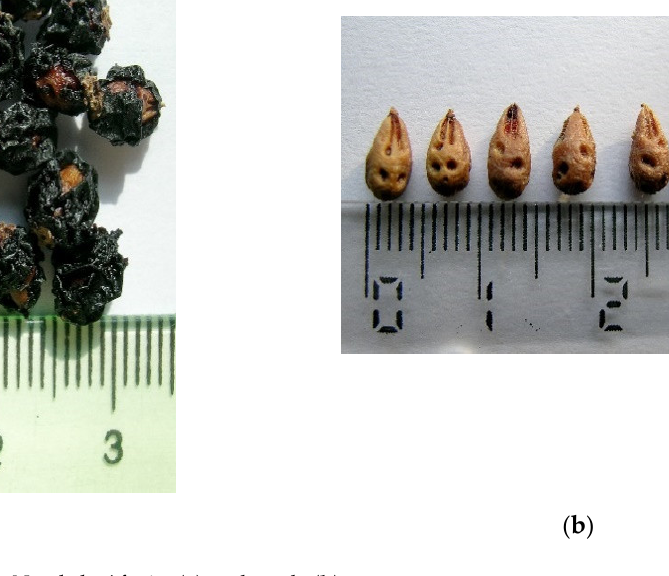
Figure 6. N. schoberi fruits ( a ) and seeds ( b ).